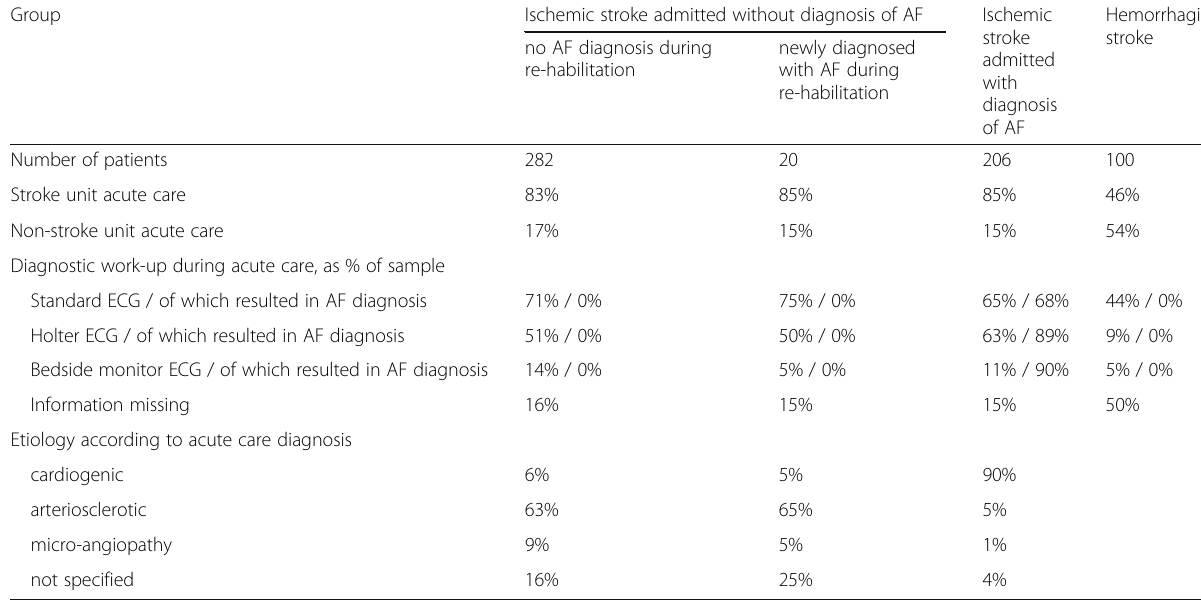
Table 2 ECG during acute care in referring hospital